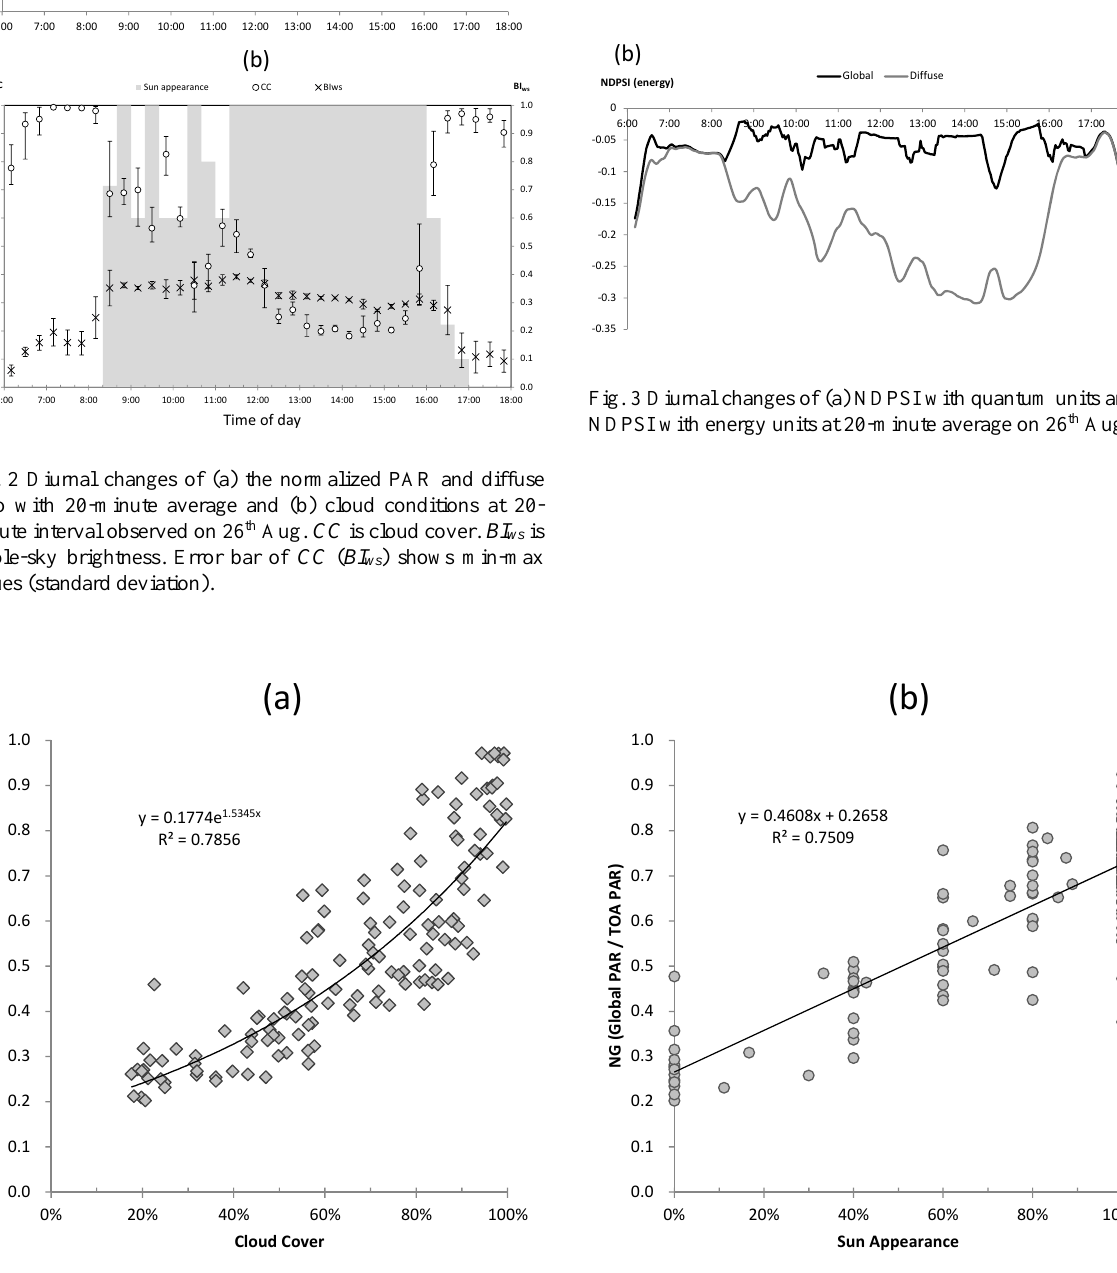
Fig.4 The relationships (a) between diffuse ratio and cloud cover, and (b) between normalized global PAR and the Sun appearance ratio.